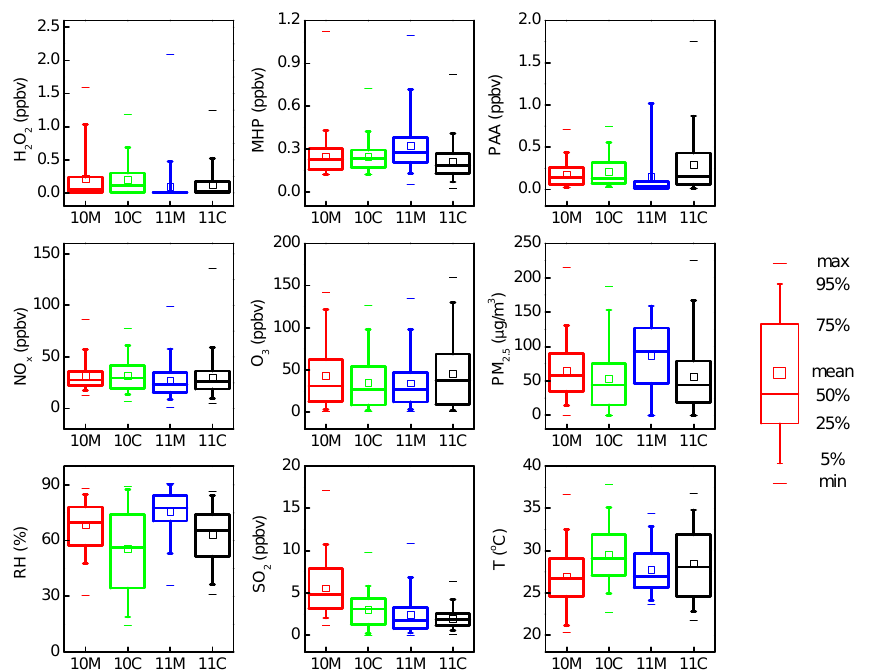
Fig. 3. Statistics for concentrations of peroxides, NO x , O 3 , PM 2 . 5 , relative humidity (RH), SO 2 , and temperature at marine and continental air mass sectors during August 2010 and August 2011. 10M: marine sector of August 2010; 10C: continental sector of August 2010; 11M: marine sector of August 2011; 11C: continental sector of August